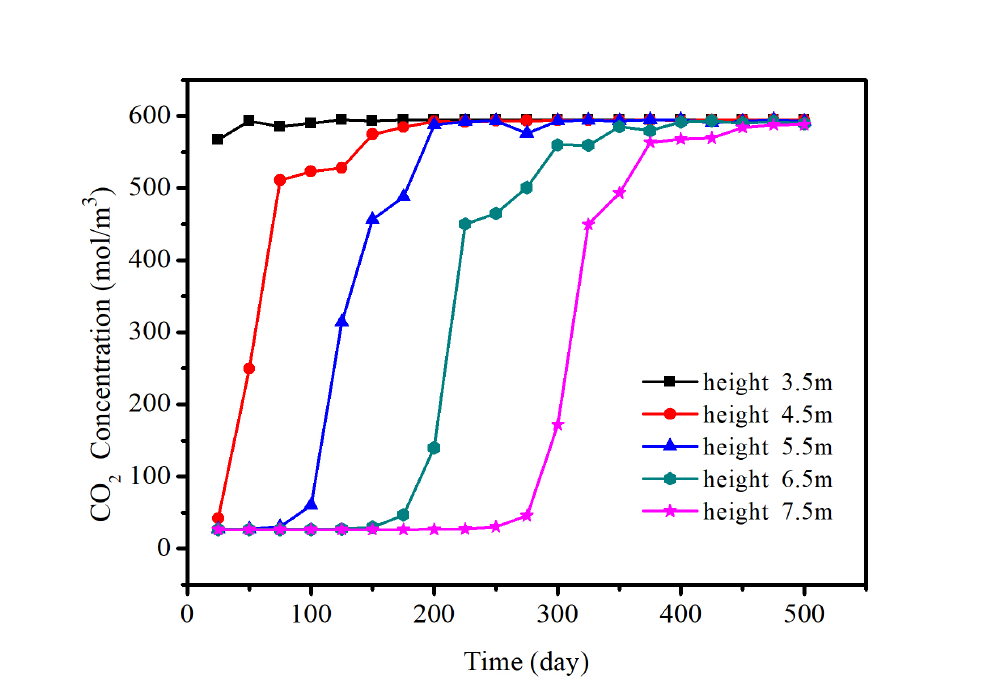
Figure 11. The variation of CO 2 concentration with time at different position at Si concentration of 3000 mol/m 3 .